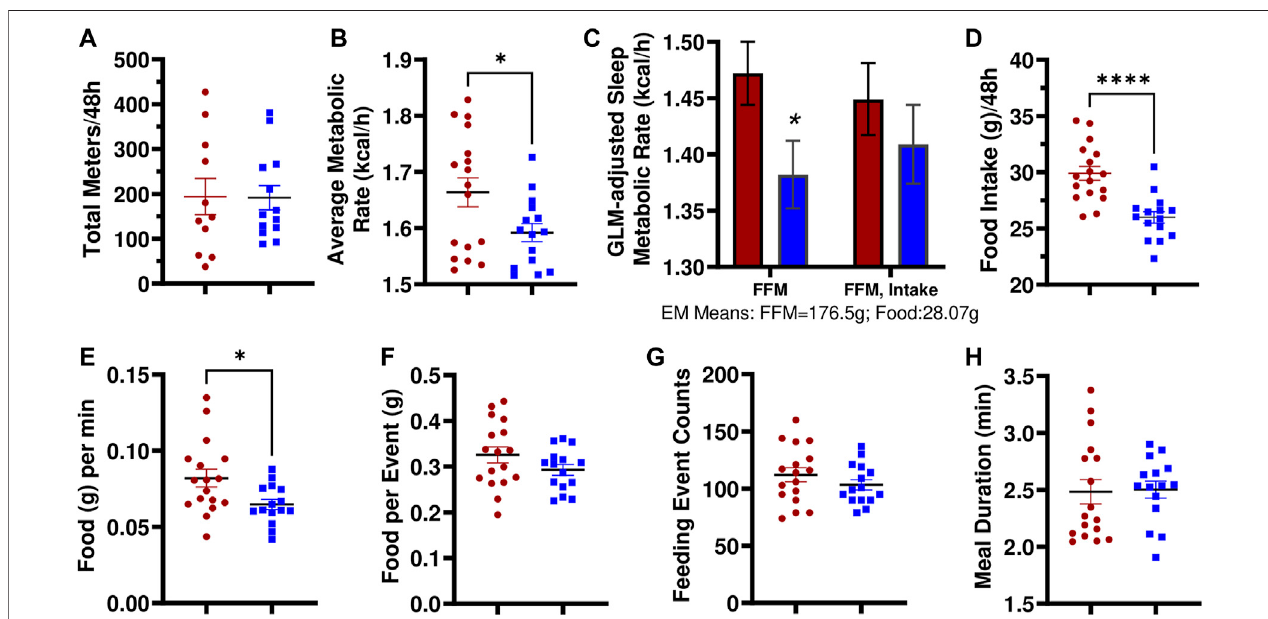
FIGURE3| LH 17 LNafemales exhibitsigni fi cantdecreases inmetabolic rateandfood intake. (A) LHand LH 17 LNafemales donotdifferintheirtotal levelsofactivity (meters traveled) (LH: red circle, n = 11; LH 17 LNa: blue square, n = 13; p = 0.955, unpaired two-tailed t-test). (B) LH 17 LNa females ’ average metabolic rate is lower ( p = 0.03, unpaired two-tailed t-test) compared to control LH females during the 48-hour data collection period. (C) Average metabolic rate during rest (de fi ned as a period longerthan5 min ofnoactivity) wasdecreasedintheLH 17 LNastrain(bluebars)( p =0.035) aftercorrectionfortheanimals ’ disparate fatfreemasses,but notonce food intake was included as a covariate (Generalized Linear Model with Estimated Marginal Means: FFM:176.5g, Food Intake: 28.07g). (D) LH 17 LNa females ingestless food during the Promethion measurement period ( p < 0.0001, unpaired two-tailed t test). The decreased food intake is driven by (E) reduced eating speed ( p = 0.0128, unpaired two-tailed t-test). No differences were seen in (F) total food intake per meal ( p = 0.143, unpaired two-tailed t-test), (G) total number of meals ( p = 0.273, unpaired two-tailed t-test), or (H) meal duration ( p = 0.682, Mann Whitney). Unless otherwise speci fi ed, LH female: red circle, n = 17, and LH 17 LNa female: blue square, n =